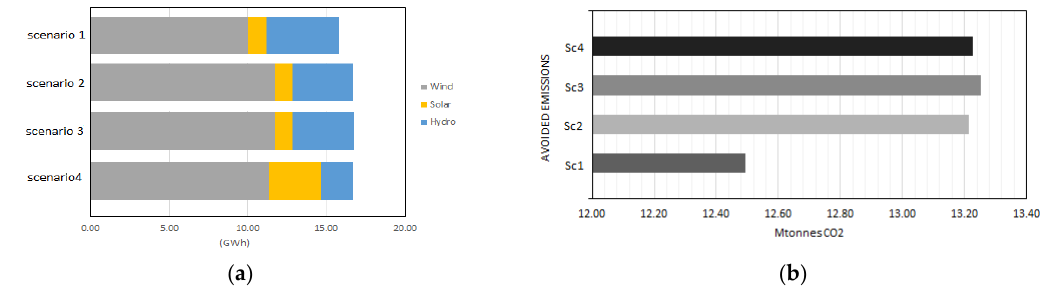
Figure 18. Electricity generated from renewables (GWh) in each scenario ( a ); total avoided emissions by each scenario ( b ).